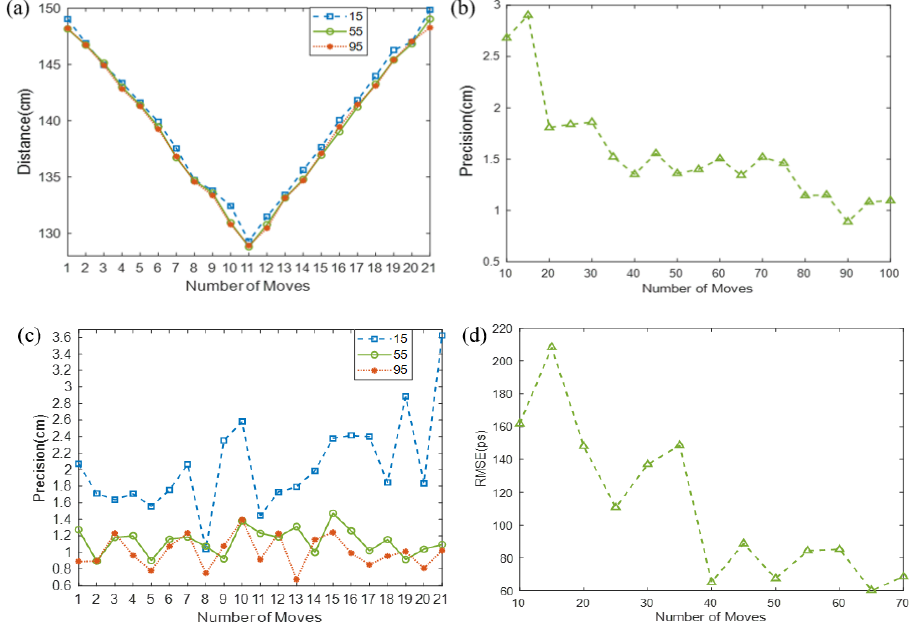
Figure 6. ( a ) Distances were measured at different locations with photon counts of 15, 55, and 95. ( b ) Single-photon-counting lidar depth precision under different photon counts. ( c ) Relationship be- tween photon counts and depth precision at different positions. ( d ) Deviation between the measured and real distances (ranging accuracy) under different photon